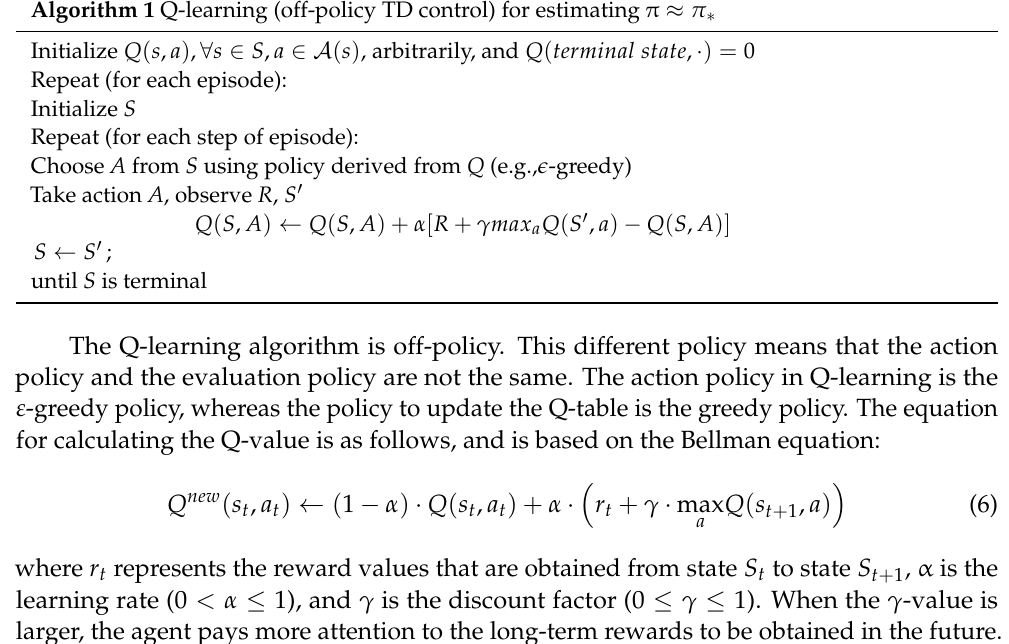
Algorithm 1 Q-learning (off-policy TD control) for estimating π (cid:3406) 𝜋